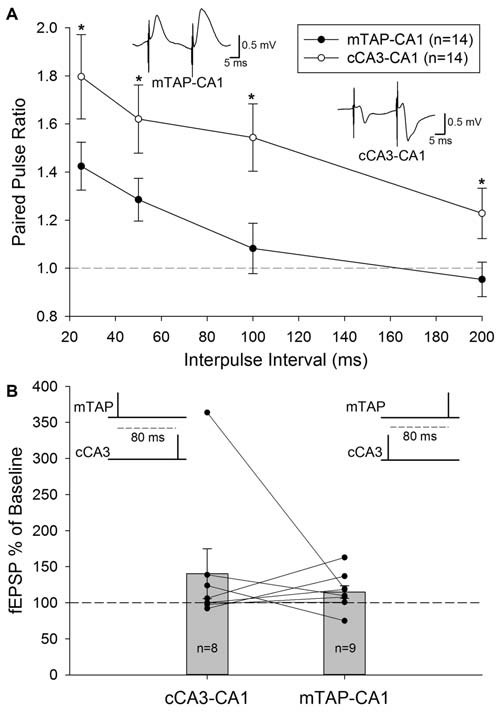
Medial temporoammonic-CA1 responses can be isolated without contamination from other perforant path targets or CA1 afferents in freely moving animals. (A) Paired pulse ratios were determined for both mTAP-CA1 (•, n = 14) and cCA3-CA1 (°, n = 14) responses collected at interpulse intervals of 25, 50, 100 and 200 ms. A *denotes p < 0.05 [repeated measures two way ANOVA]. Inset responses depict representative examples of mTAP-CA1 and cCA3-CA1 paired pulse facilitation following a 25 ms interpulse interval. Calibration: 0.5 mV, 5 ms. (B) Heterosynaptic facilitation is not reliably observed with heterosynaptic paired pulse stimulation of CA1 afferents in freely moving animals. Normalized cCA3-CA1 (n = 8) and mTAP-CA1 (n = 9) field EPSPs evoked with a heterosynaptic paired pulse stimulation interval of 80 ms. Data are represented as mean ± SEM. Symbols (•) reflect individual experiments and symmetrical data recordings of individual animals are shown as lines.